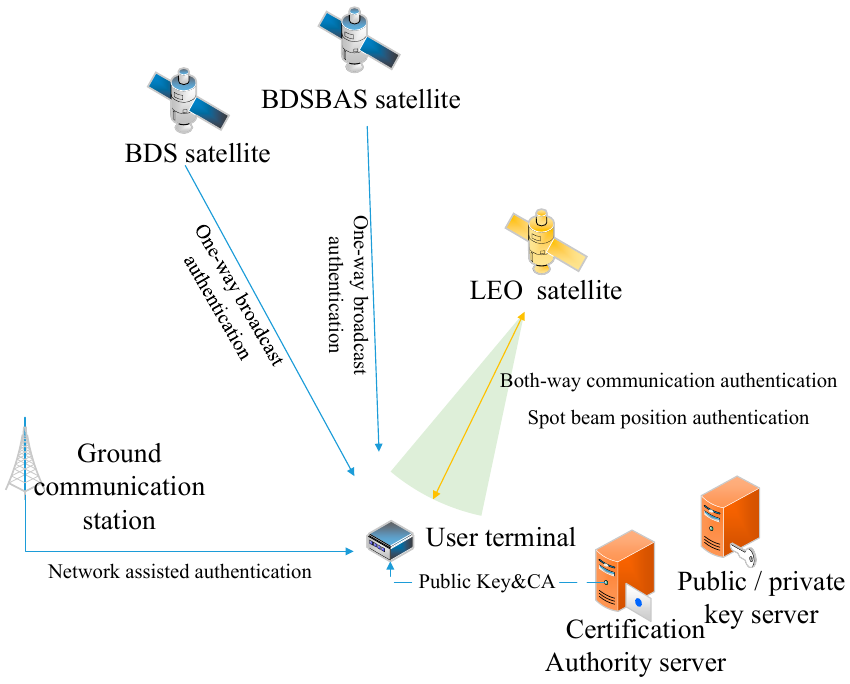
Figure 8. Authentication service architecture for BDS.